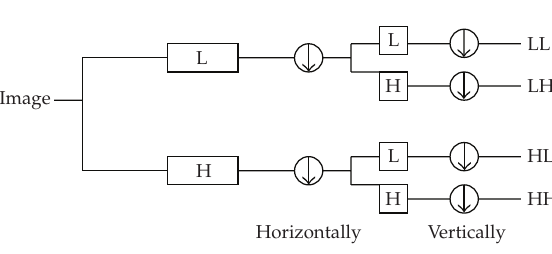
Figure 2: Discrete wavelet transform of an image (cid:3) single level (cid:4) . L—Low Pass Filter; H—High Pass Filter. LL—Approximation coe ffi cients (cid:3) High scale, low frequency (cid:4) —cA 1 . LH, HL and HH– Detail coe ffi cients (cid:3) low scale, high frequency (cid:4) —cH 1 , cV 1 and cD 1 .